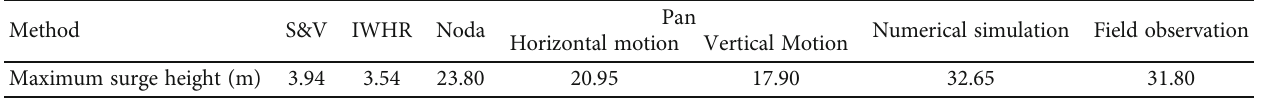
Table 4: Maximum surge height using various